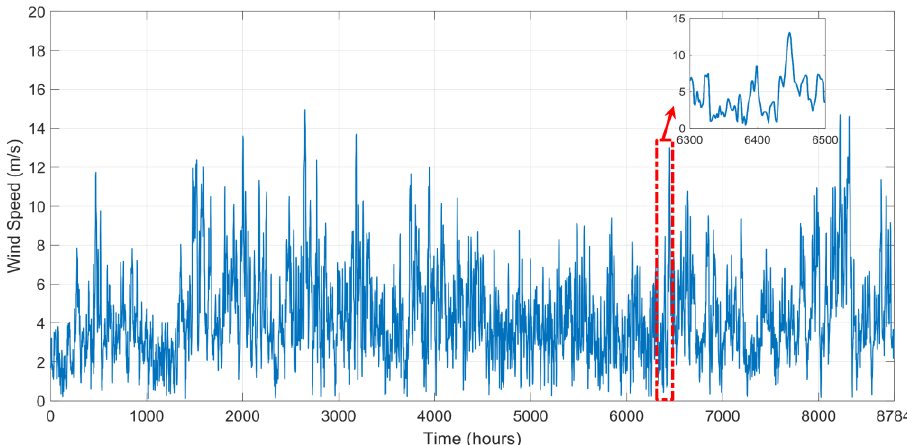
Figure 4. Annual solar radiation of the studied site.